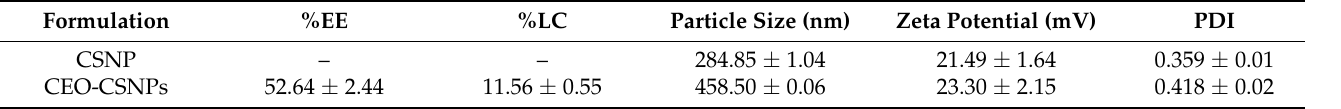
Table 4. Characterization of the optimized CEO-loaded CSNPs in terms of encapsulation efficiency, loading capacity, mean hydrodynamic particle size, polydispersity index (PDI), and zeta potential. Formulation